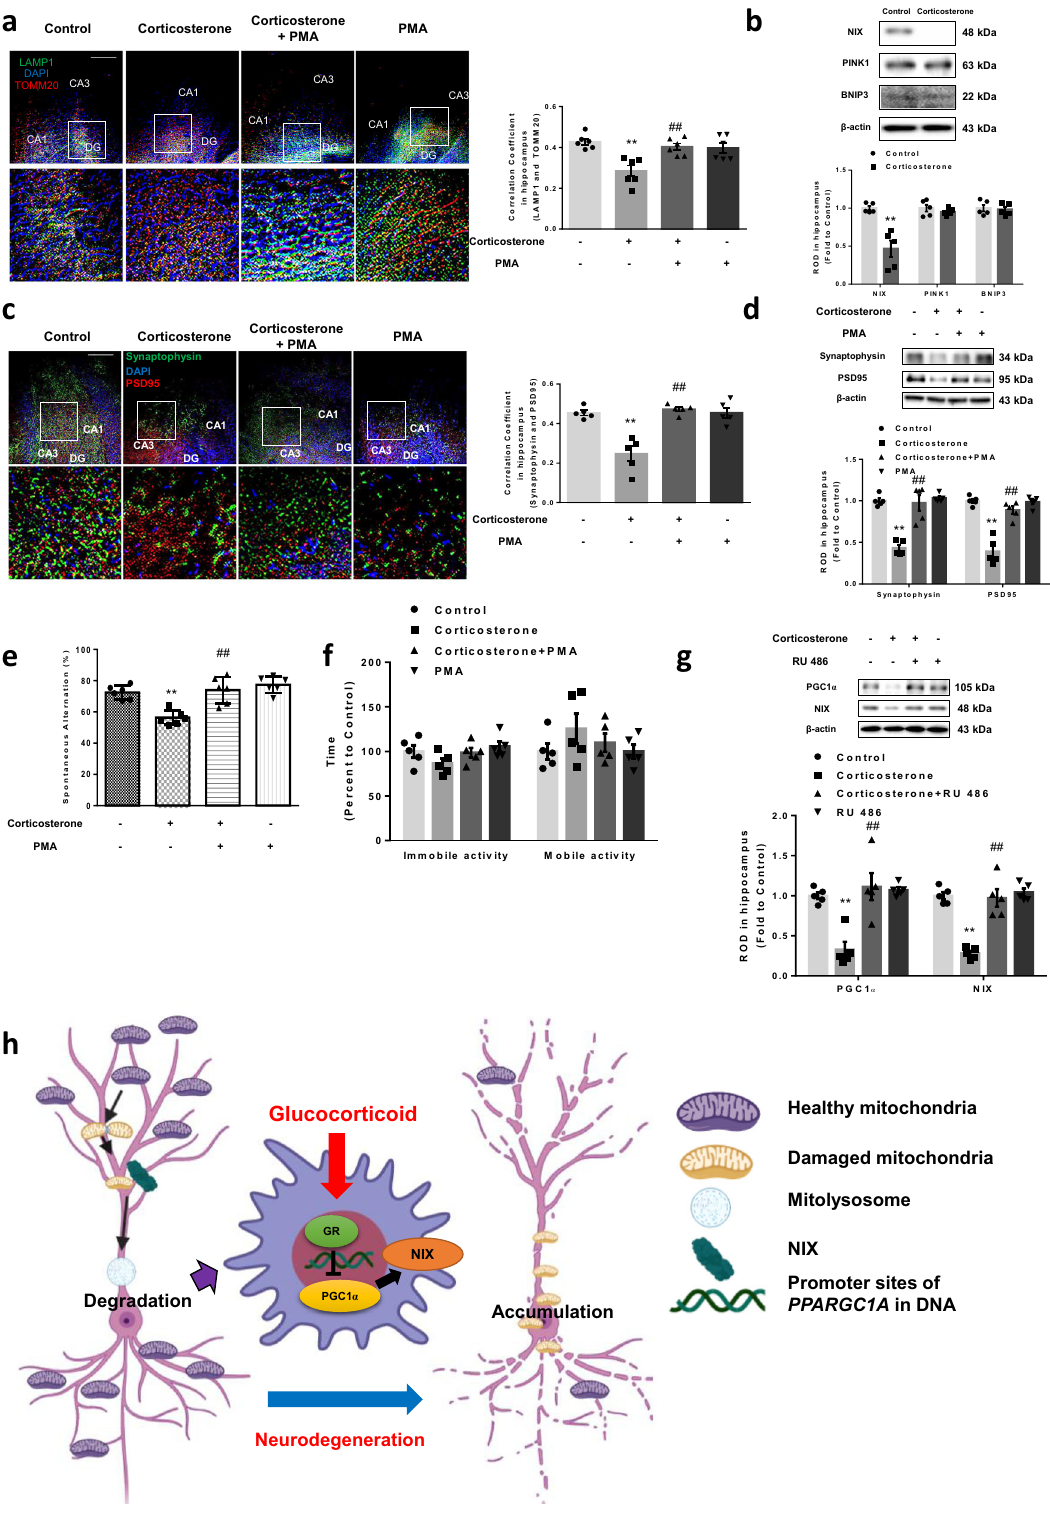
Transfection of siRNA for gene silencing . Cells were grown until 60% con fl uency Lipid-based transfection method with lipofectamine 3000 was used in of the plate. Prior to corticosterone and cortisol treatment, cells were incubated neuron coverslips into a 12-well plate following modi fi ed protocol 62 . with 25nM of the indicated siRNAs and turbofect transfection reagent (Thermo After 60 – 90 min, neurons were replaced with fresh neurobasal media contain- Fisher) for 24 h according to the manufacturer ’ s instructions. The siRNAs speci fi c ing 2% B27 supplement. SH-SY5Y cells were transfected with plasmids for human/mouse GR are purchased from Bioneer Corporation (Daejeon, Korea). using lipofectamine 3000 following modi fi ed protocol 63 . After incubation The siRNAs speci fi c for human BNIP3L and nontargeting (NT) are obtained from for 6 h, lipofectamine reagent was removed and replaced with fresh starvation Dharmacon (Lafayette, CO, USA). media. NATURE COMMUNICATIONS| (2021) 12:487